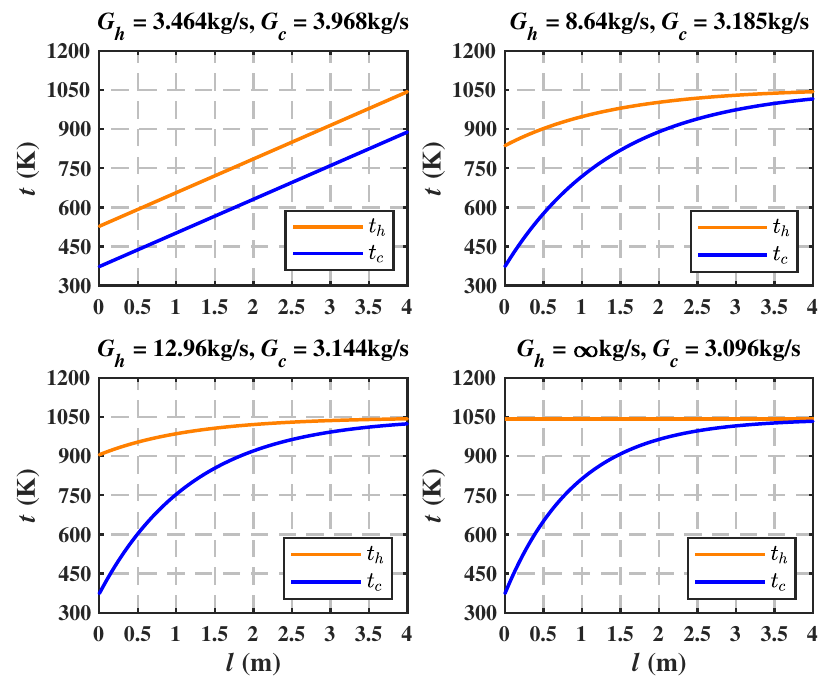
Figure 14. Four pairs of heat capacity rates to realize a specific amount of heat transfer.